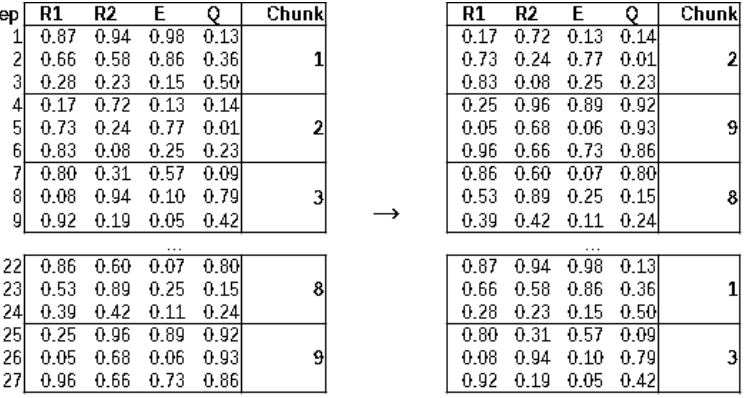
Figure 6. Example of shuffling data which include time series of rainfall (R1 and R2), evapotranspira- tion (E), and discharge (Q). R1, R2 and E exemplify the hydrological model inputs and can vary in number and type from a case study to another. The chunk size of this example is equal to 3 (much smaller than the actual size used in the case studies for the sake of the figure